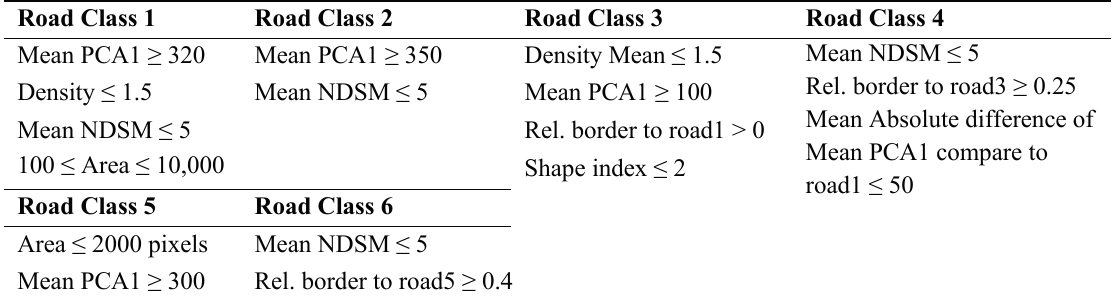
Table 2. Classification Specification for Road Classes.